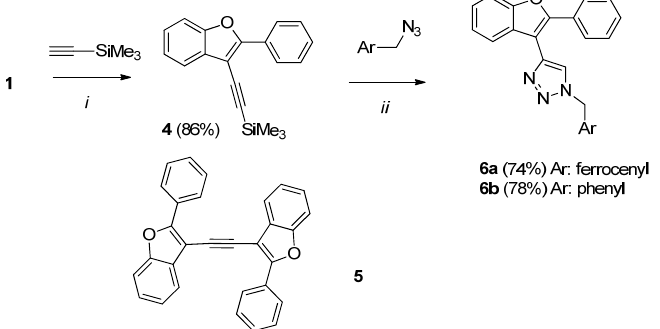
Scheme 4. Synthesis of benzofuran-triazole-ferrocene hybrid 6a and its Ph analogue 6b (Reaction